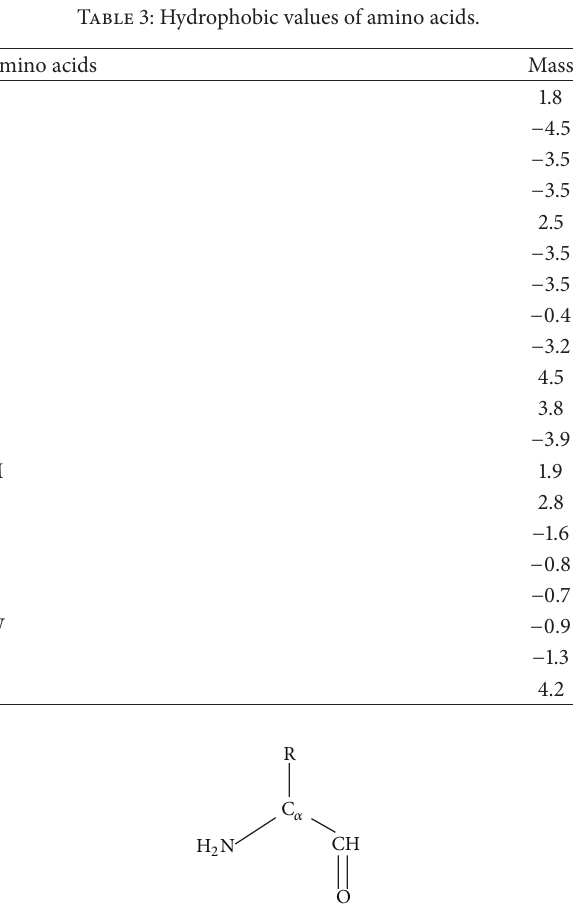
Figure 3: Basic structure of amino